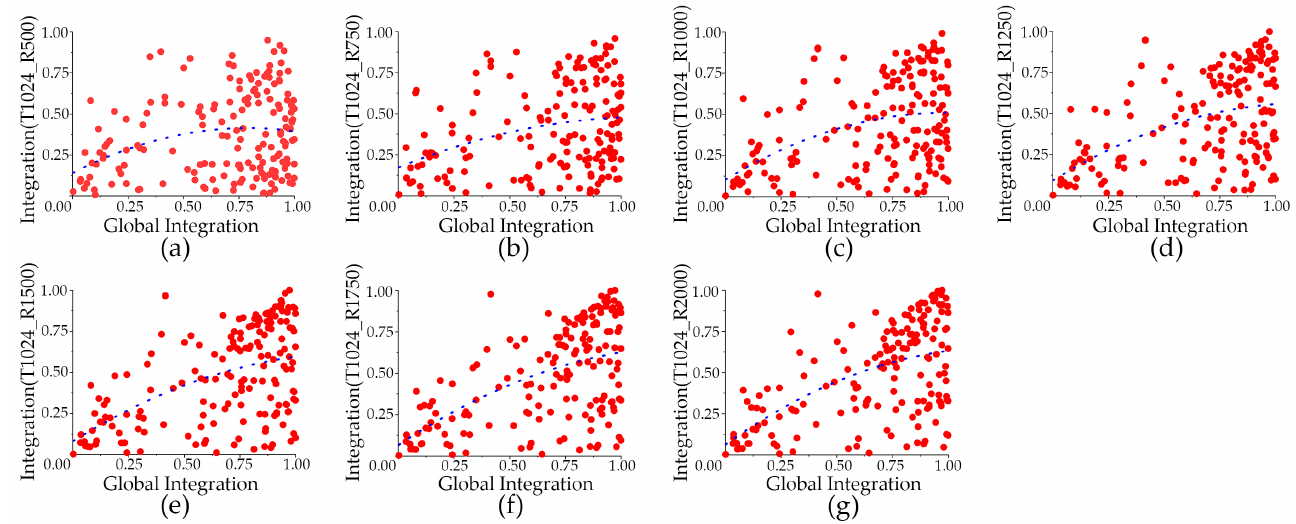
Figure 8. Global integration and through angle and limit distance range fitted curves plot: ( a ) Global